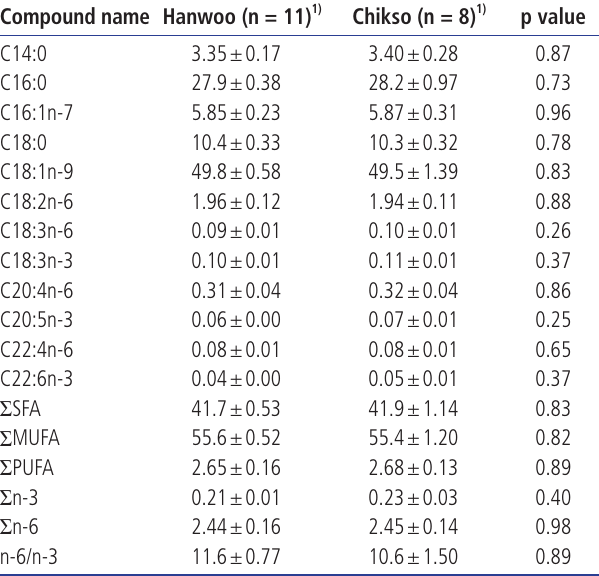
Table 3. Instrumental color and meat quality traits of strip loin from Hanwoo and Chikso steers finished under same diet Trait